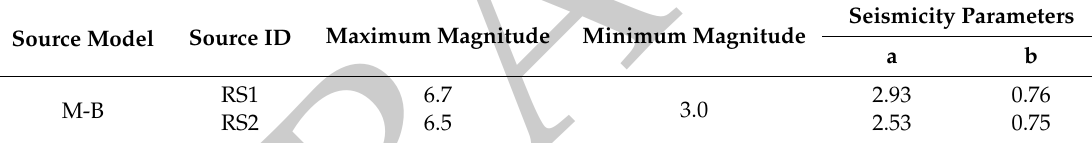
Table 5. Seismic source coordinate for model